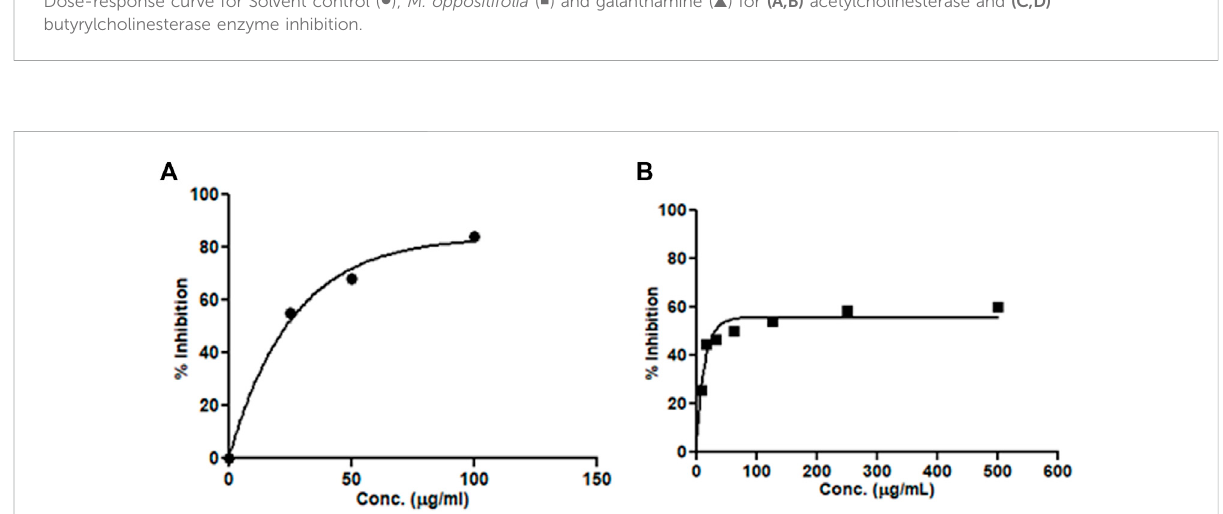
(cid:129) ); M. oppositifolia ( ■ ) and galanthamine ( ▲ ) for (A,B) acetylcholinesterase and (C,D)